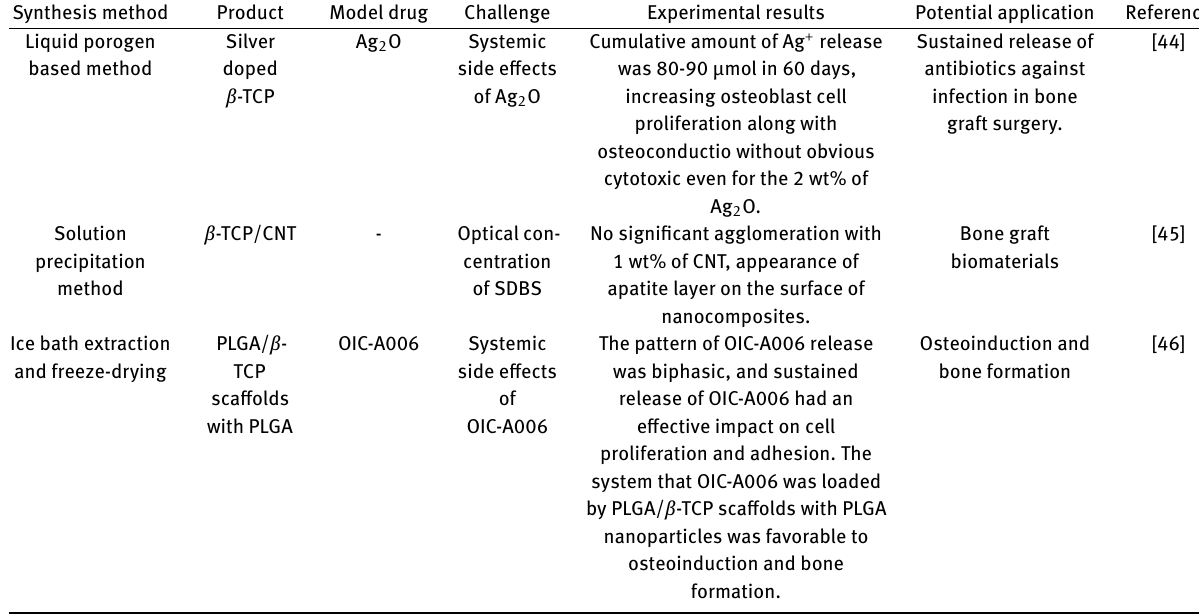
Table 5: Potential application of β -TCP in the field of DDS Synthesis